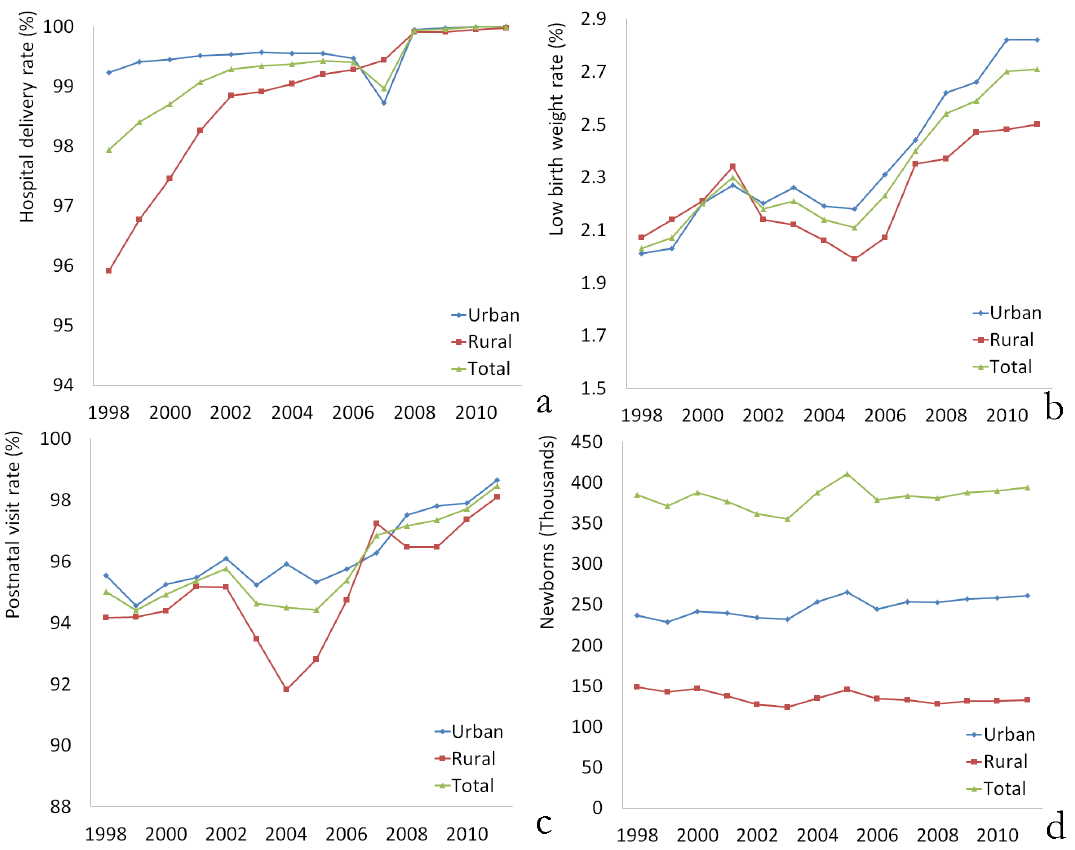
Table 2. The breastfeeding rate (%) within the first 4 months and the prevalence of underweight (%) among children under 5 years old.